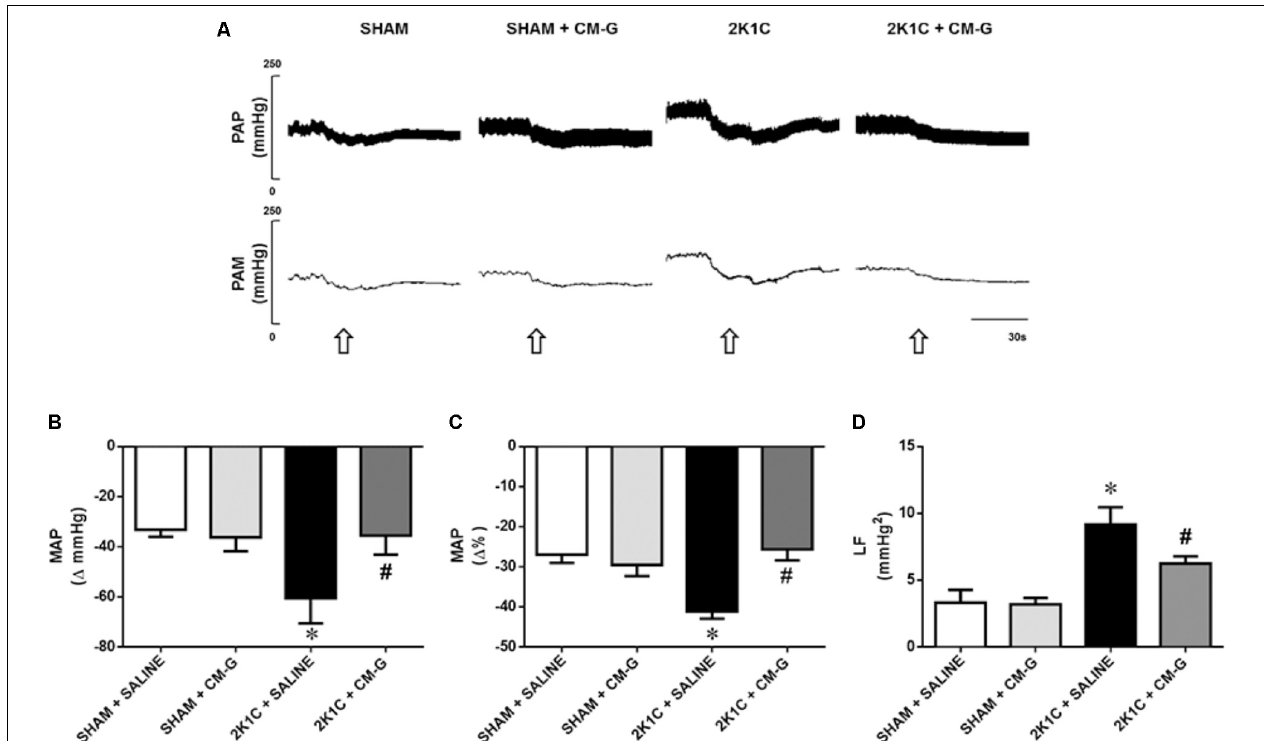
FIGURE 4 | Oral administration of carboxymethyl-glucan (CM-G) reduces sympathetic tone in renovascular hypertensive rats (A) Original tracings from one representative animal from each group (Sham + Saline, Sham + CM-G, 2K1C + Saline, 2K1C + CM-G) showing changes in pulse arterial pressure (PAP) and mean arterial pressure (MAP) in response to ganglionic blocker with hexamethonium (30 µ g/Kg, i.v., open arrows). (B) Effects of oral administration of CM-G for 2 weeks on the evaluation of delta change of the MAP after blockade with hexamethonium. (C) Data now presented as percentage changes in MAP after blockade with hexamethonium. (d) Values of low frequency component (LF) of each group showing that oral administration of carboxymethyl-glucan (CM-G) reduces neurogenic sympathetic vasomotor activity in renovascular hypertensive rats. ∗ P < 0.05 2K1C + SALINE vs SHAM + SALINE; # P < 0.05 2K1C + CM-G vs 2 K1C +